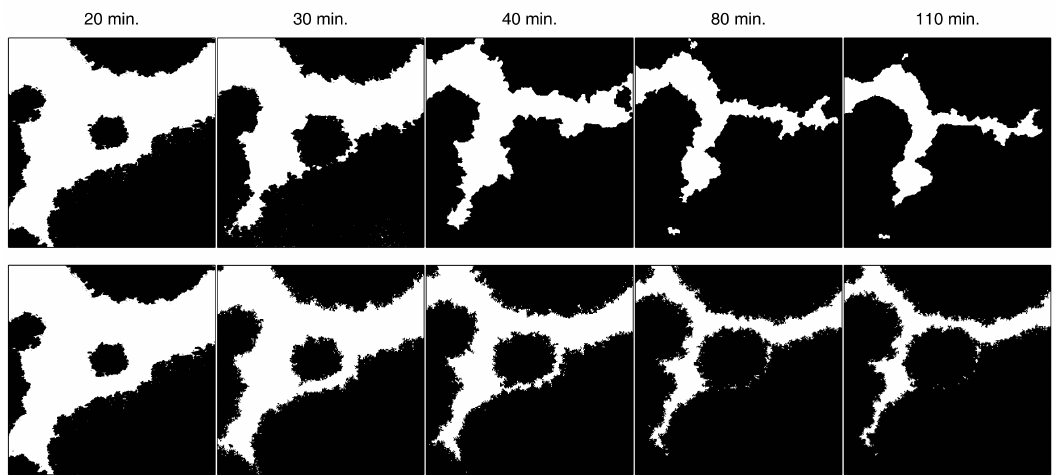
Figure 9. Comparison between real images ( up ) and simulation ( down ) at different times, with initial data corresponding to the real data at 20 min. The values of the structural parameters taken in the simulation are β = 1, α = 0.5, and r inf = n /8 (with n = 256). The kinetic parameters have been set to fit the real data, according to the Avrami–Gompertz model